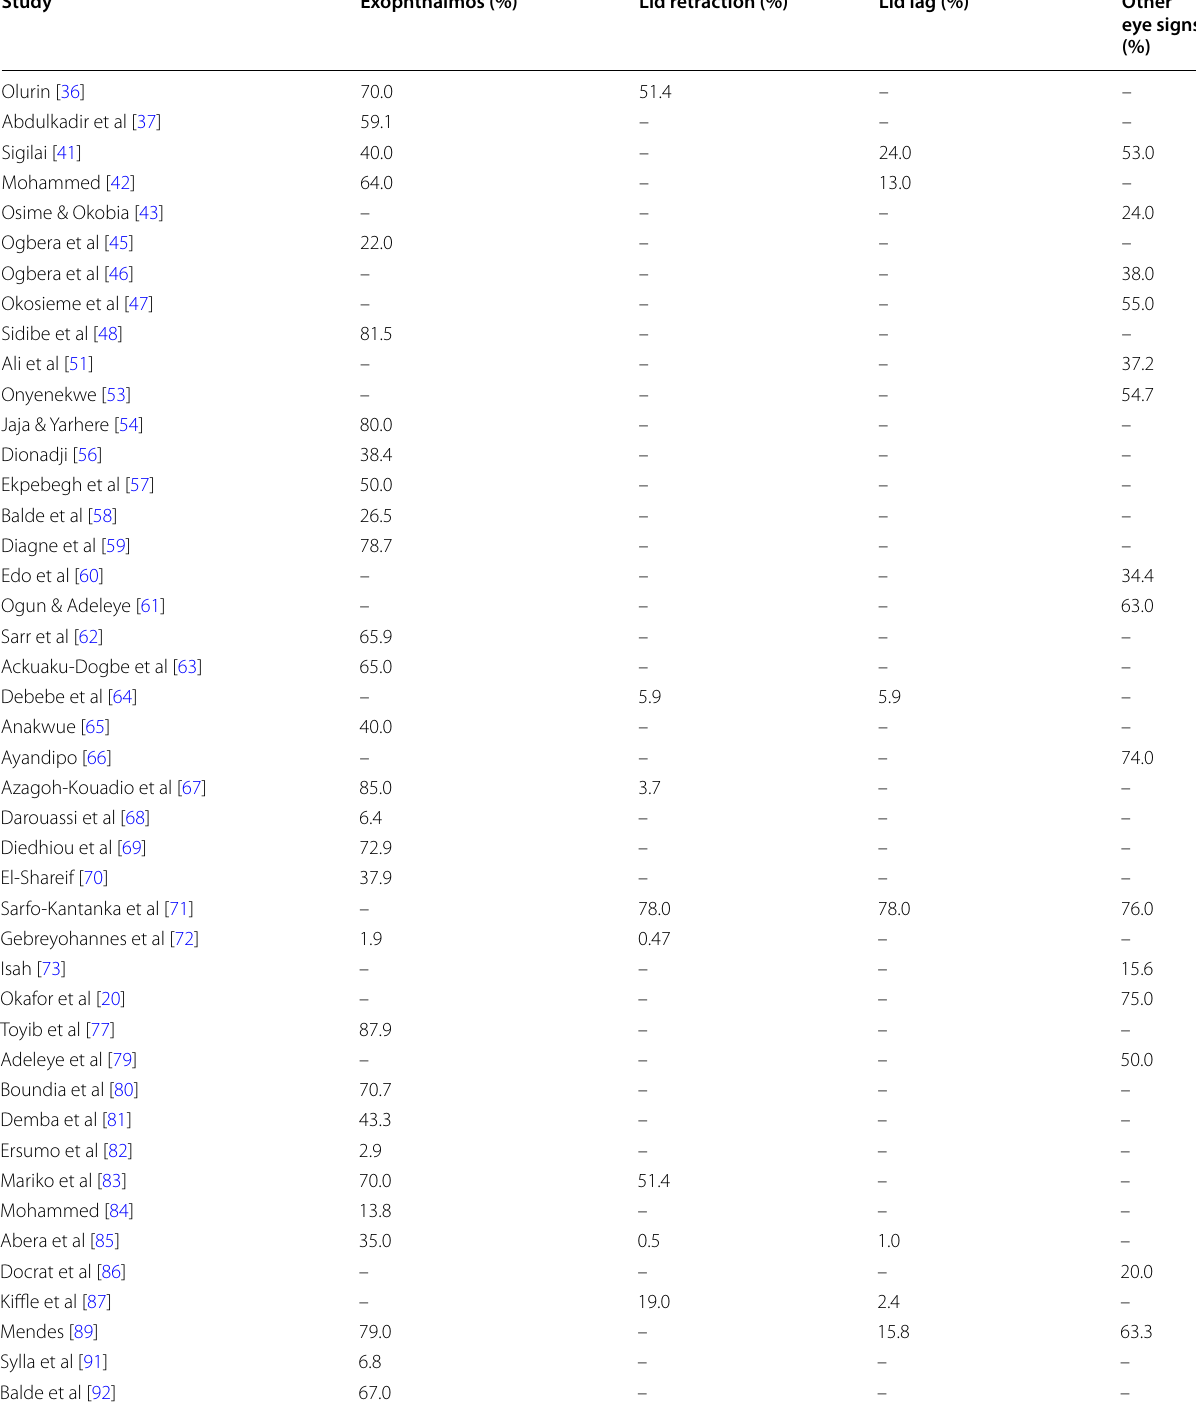
Table 9 Ophthalmological